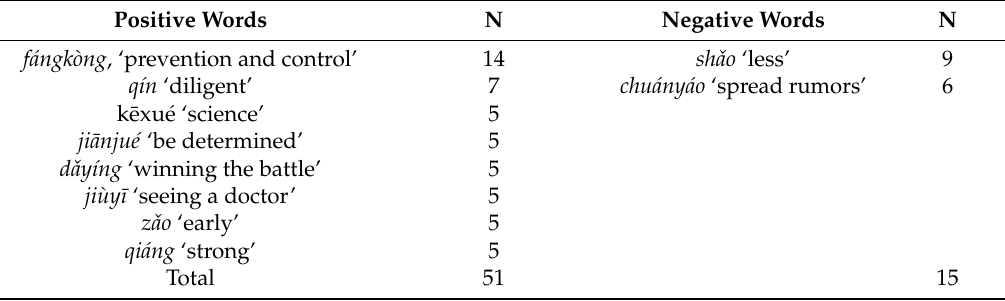
Table 4. Words with frequencies of 5 and over that appeared in ‘O ffi cial’ banners; N = 66. Positive Words N Negative Words N f á ngk ò ng , ‘prevention and